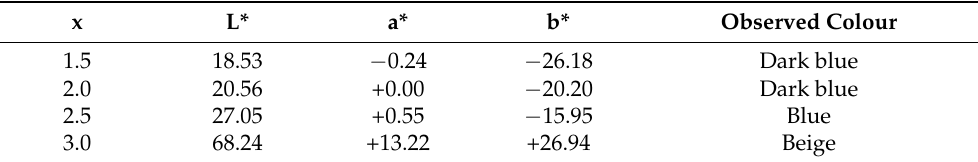
Table 6. CIE L* a* b* colour parameters from the glazed tiles obtained from the Mg x Co 3 − x P 2 O 8 (1.5 ◦ ≤ x ≤ 3.0) materials fired at 1200